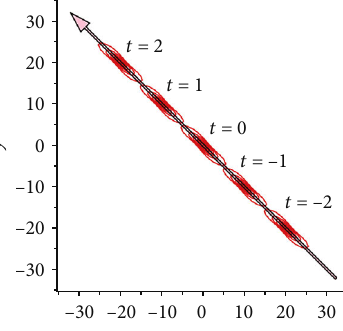
Figure 5: Position and trajectory of 1-lump soliton at di ff erent